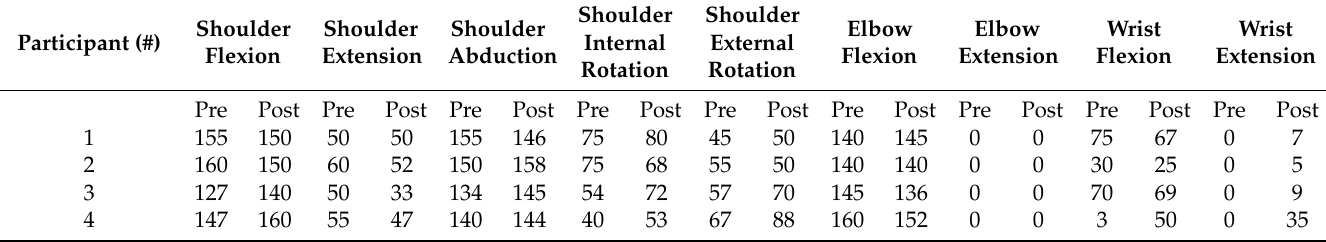
Table 2. The pre- and post-intervention upper extremity joint active range of motion results for the